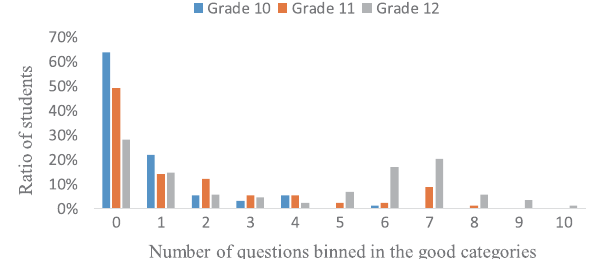
FIG. 2. Percentage of good categories created by students in different grades. The horizontal axis is the number of questions in the good categories, and the vertical axis is the percentage of students in different grades (grade 10-blue, grade 11-orange, grade